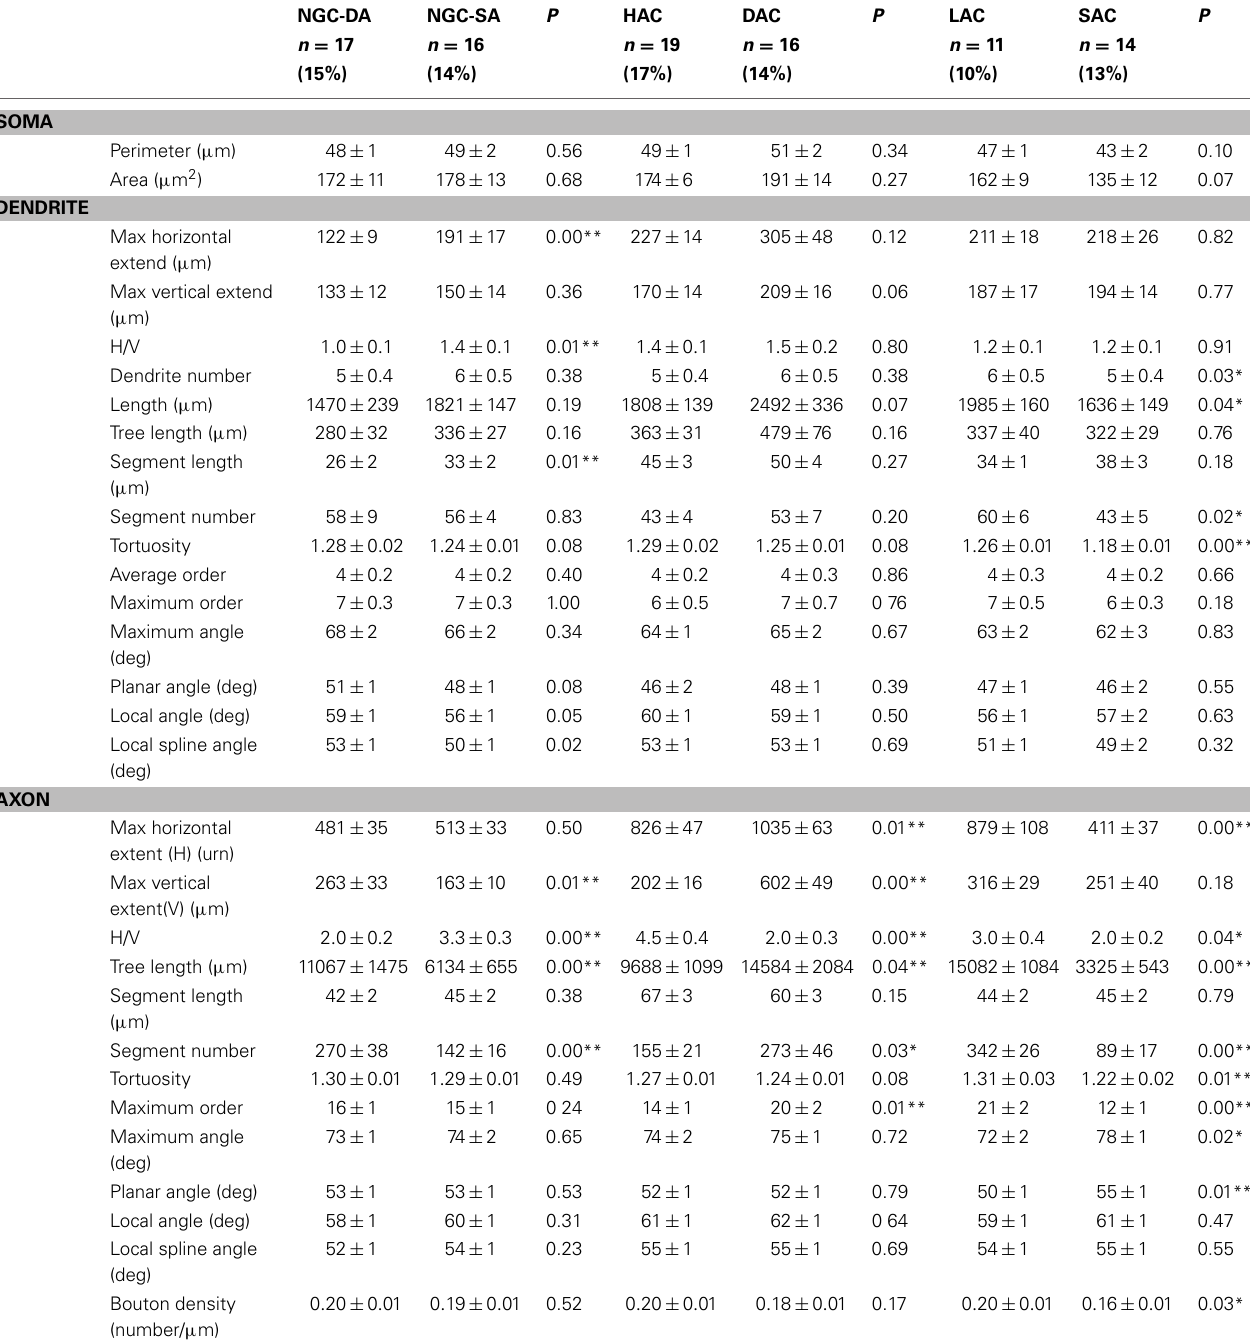
Table 1 | Summary of the expert chosen morphometric parameters of soma, dendrites and axon, of the 6 groups of L1 cells, with their corresponding